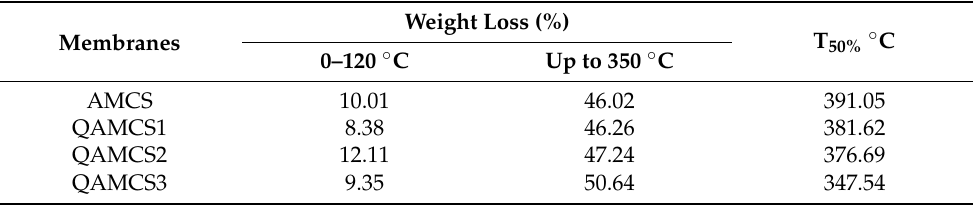
Table 1. TGA data for the developed aminochitosan, quaternized aminochitosan 1, quaternized aminochitosan 2 and quaternized aminochitosan 3